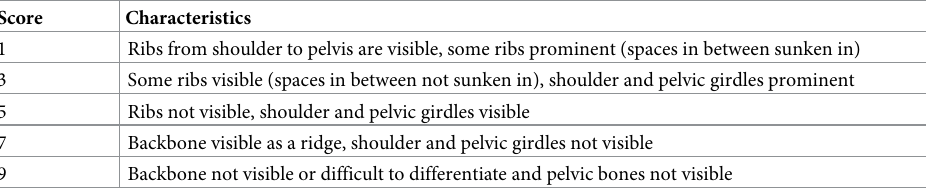
Table 2. Diagnostic characteristics pertaining to scores in photographic scale.